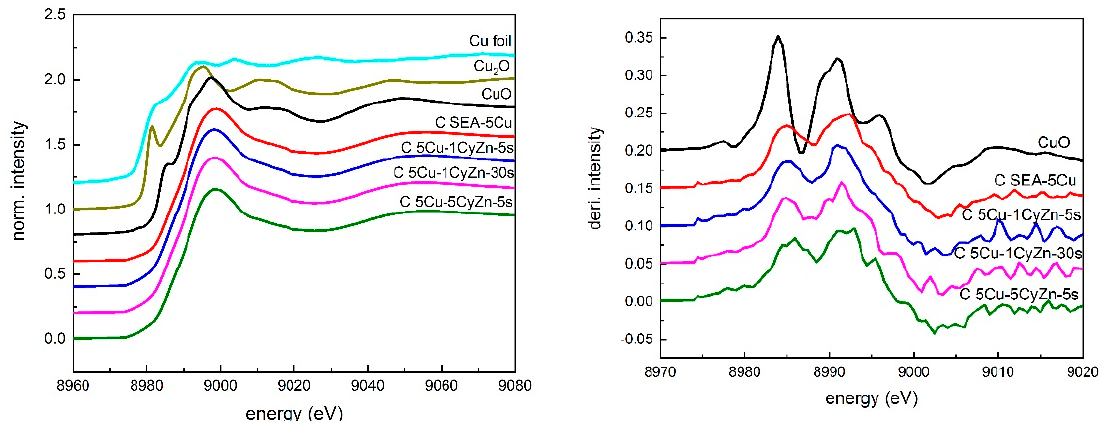
Figure 7. Experimental XANES spectra registered Cu K-edge of SEA-5Cu and ZnO over-coated Cu/SiO 2 catalysts ( left ). The first derivative XANES spectra ( right ).